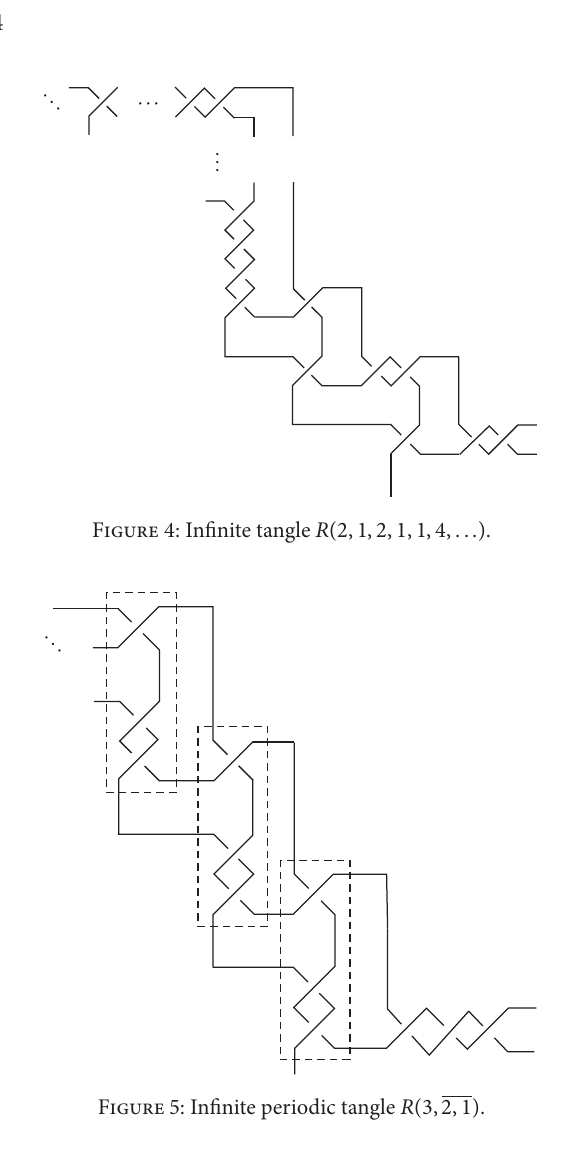
Figure 4. (3) Considering a quadratic irrational number (5+ √ 3)/2 , 𝑅((5 + √3)/2) = 𝑅(3, 2, 1, 2, 1, . . .) = 𝑅(3, 2, 1) is an infinite periodic tangle of quadratic irrational number (5+√3)/2 . See Figure 5. In Figure 5, the boxes mean periodic parts as 𝑅(2, 1)